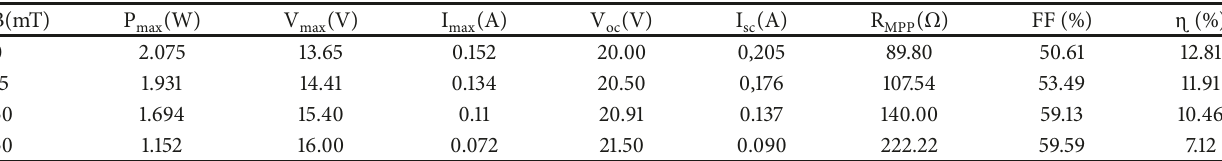
Table 4: Electrical parameters of the photovoltaic module against the intensity of the magnetic field and for a solar irradiance of 600 W/m 2 .